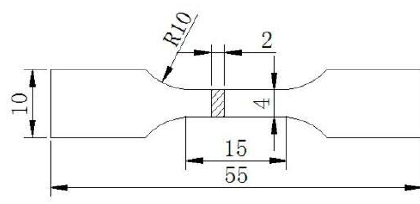
Figure 1. Tensile specimen size (mm).